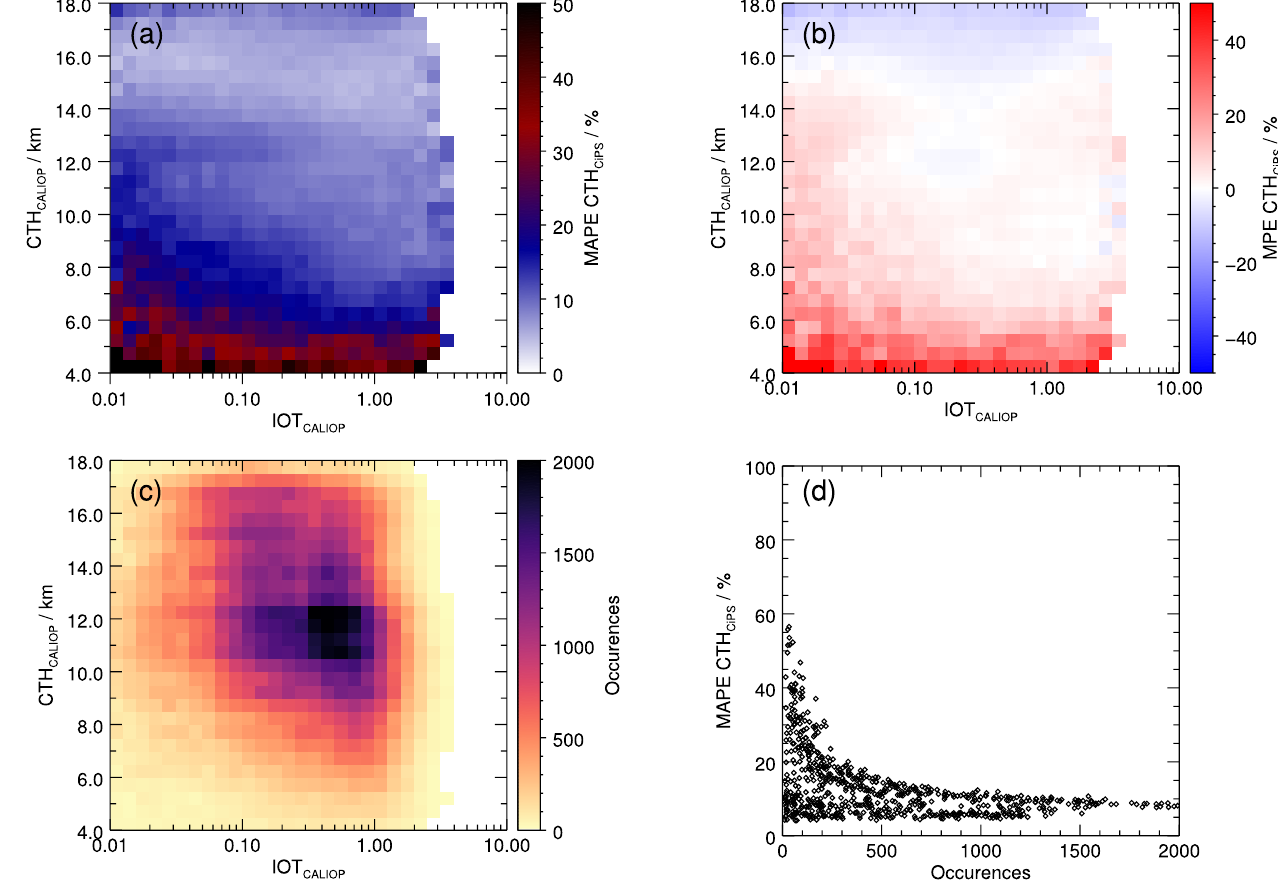
Figure 9. (a) Two-dimensional histogram showing the MAPE of the CTH CiPS retrievals as a function of the reference retrieval quantities IOT CALIOP and CTH CALIOP . (b) Two-dimensional histogram showing the MPE of the CTH CiPS retrievals as a function of IOT CALIOP and CTH CALIOP . (c) Two-dimensional histogram showing the number of occurrences for different combinations of IOT CALIOP and CTH CALIOP . (d) The MAPE of the CTH CiPS retrievals for the different IOT CALIOP / CTH CALIOP combinations as a function of the number of occurrences (each diamond represents two corresponding grid boxes in a and c